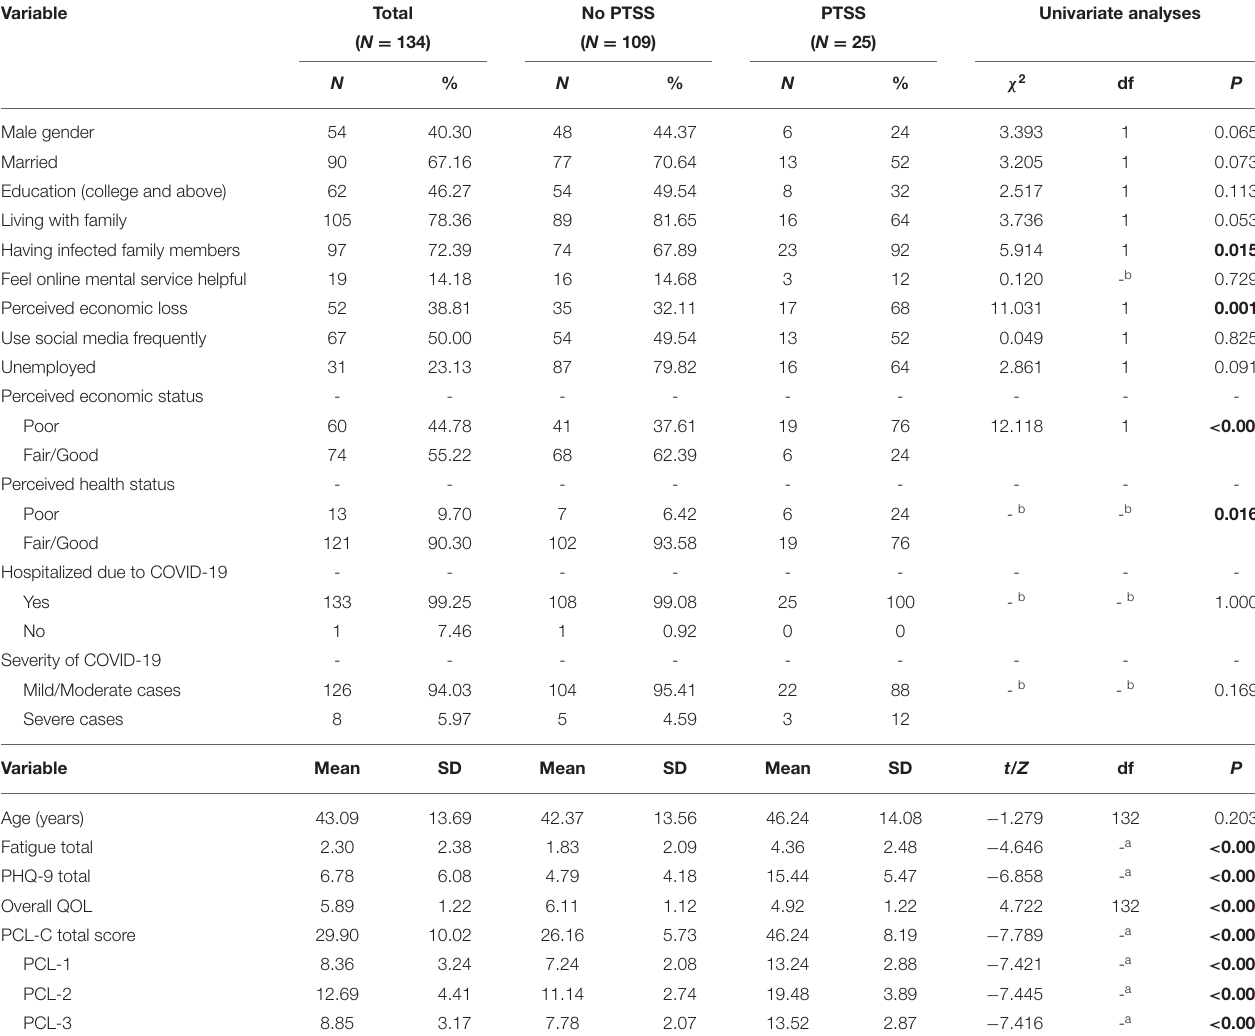
TABLE 2 | Differences between COVID-19 survivors with PTSS and those without.